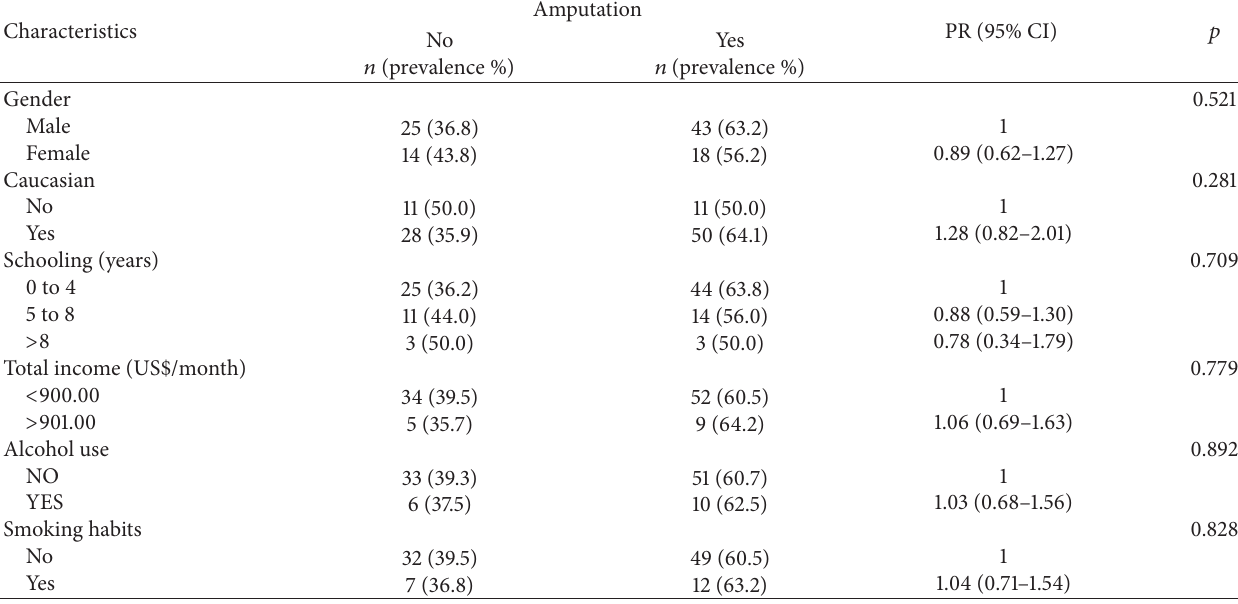
Table 1: Distribution of patients with diabetes by their sociodemographic characteristics and outcomes for diabetic foot amputation.